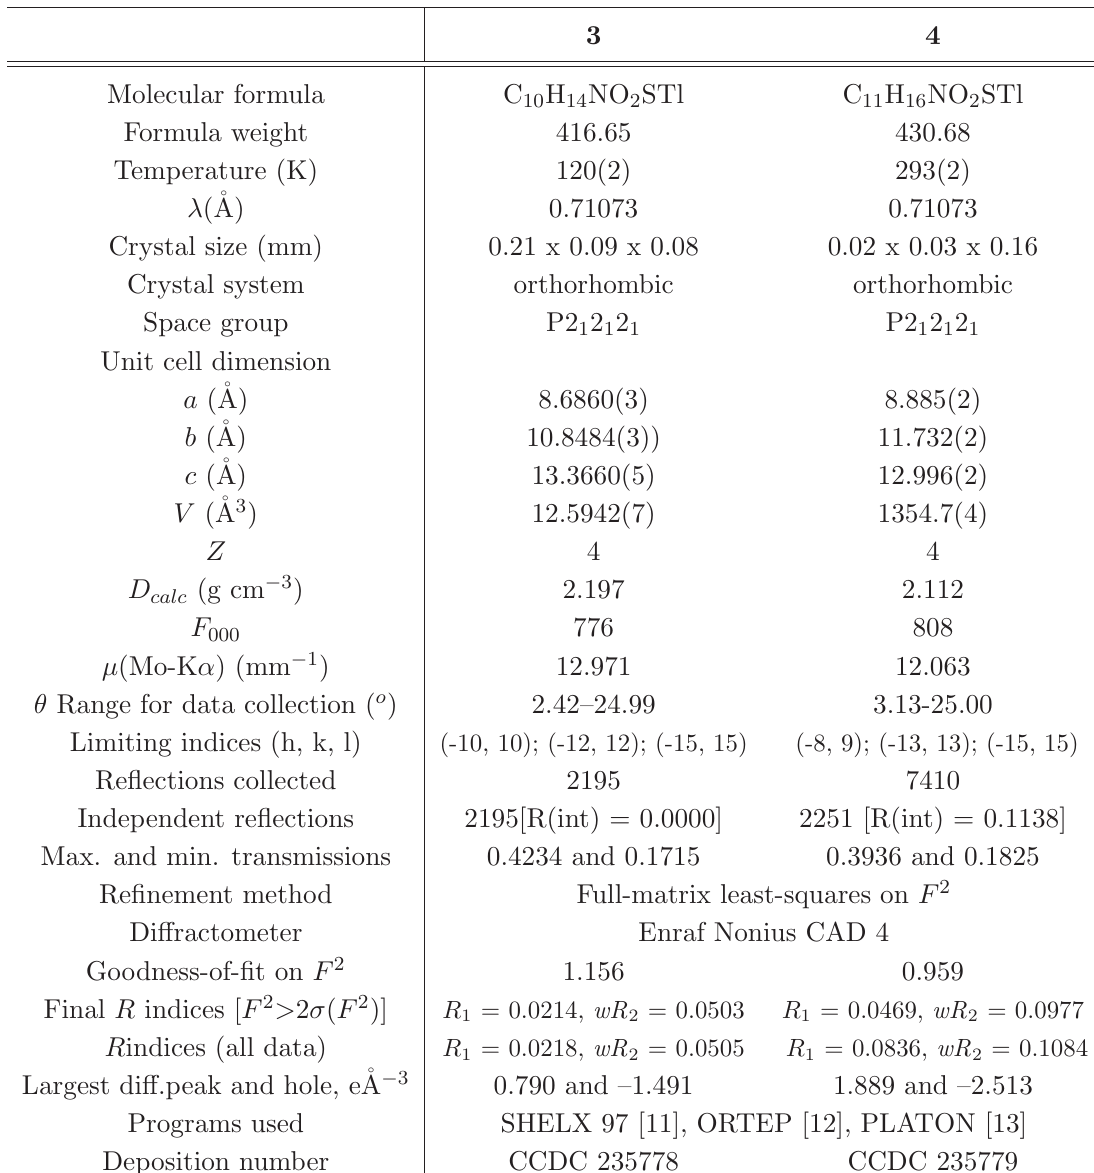
Table 4 Crystal data and details of structure refinement for [TlMe 2 (2men)] ( 3 ) and [TlMe 2 (2min)] ( 4